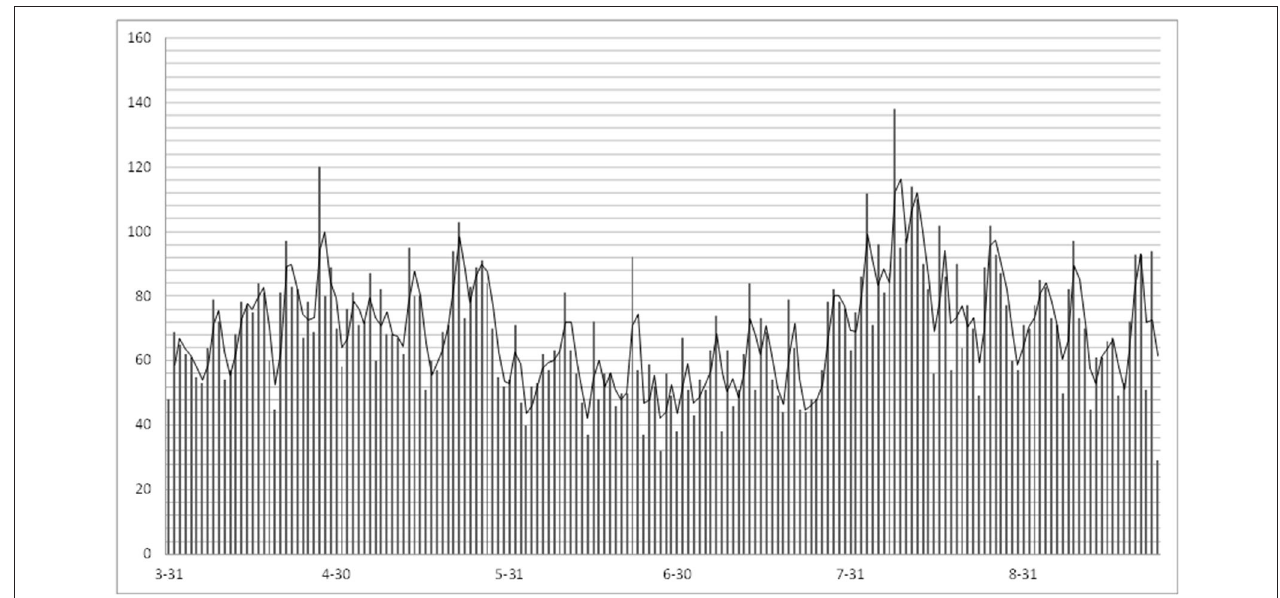
FIGURE 6 | Trend chart of daily user visits.